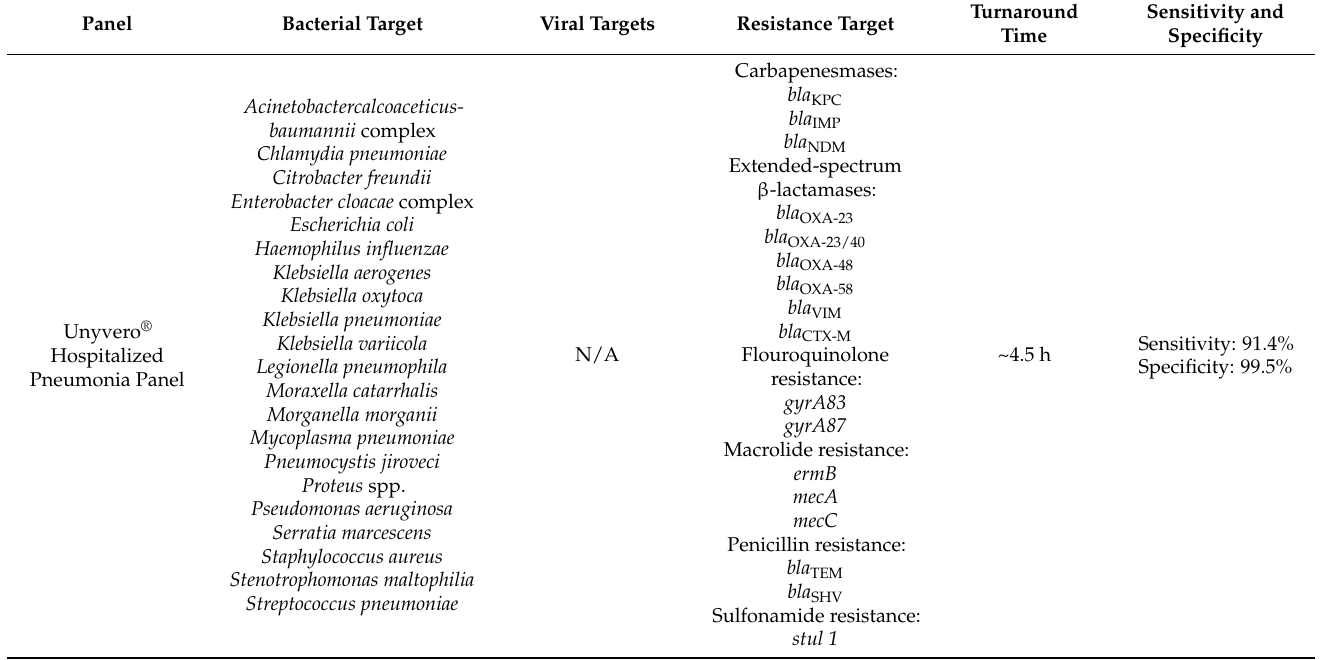
Table 2. Comparison of Various Rapid Respiratory Panels Continued